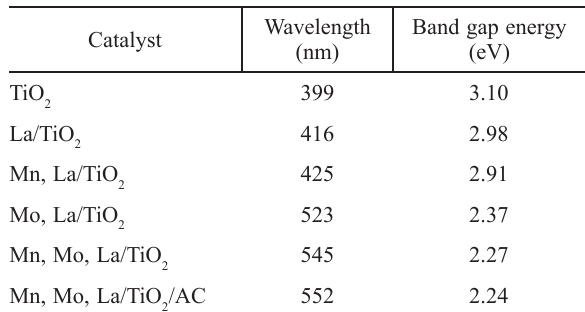
Fig. 6 – Effect of Mn, Mo, la/Tio age on RR 198 photo-degradation (pH: 3, RR 198: 60 mg l –1 , irradiation: visible